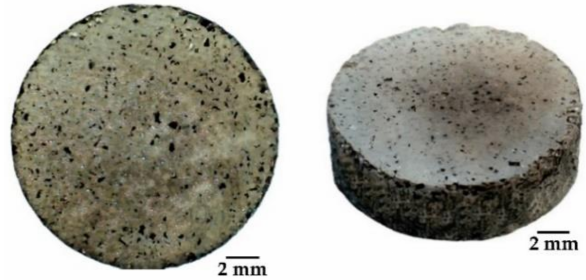
Figure 6. Sintered Al foams with 70 vol.% design